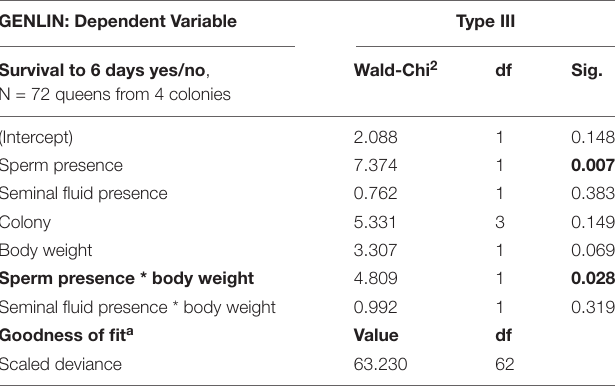
TABLE 1 | Comparing inseminations involving sperm ( N = 16 for full ejaculates and N = 16 for sperm only, giving a total of N = 32) and “inseminations” involving no sperm ( N = 14 for both seminal fluid only and Hayes saline, and N = 12 for sham treatment, giving a total of N = 40), produced a significant main effect of sperm presence and a significant interaction term between sperm presence and body weight, indicating that heavier queens of A. colombica were more likely to survive to the end of the experiment than lighter ones. After “insemination” involving seminal fluid, we neither found a significant main effect nor a significant interaction term with body weight ( Figure 2 ).